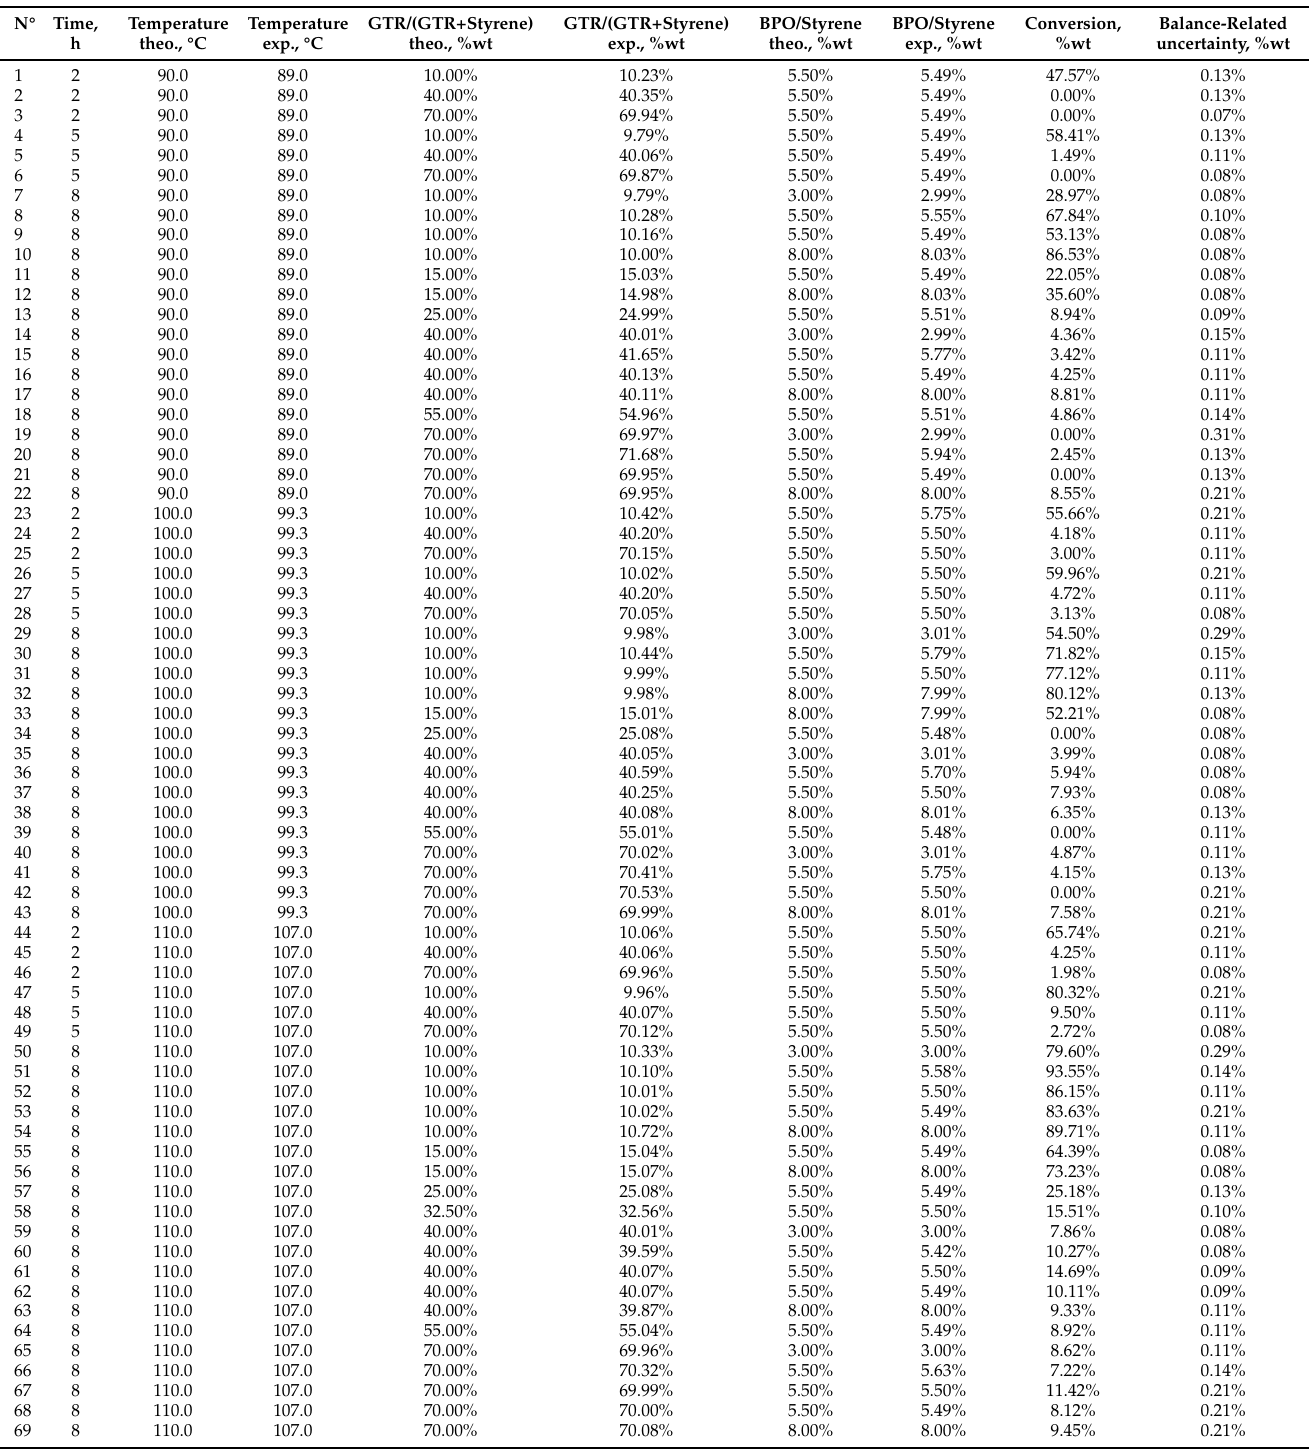
Table C1. Experimental results for the small-sized